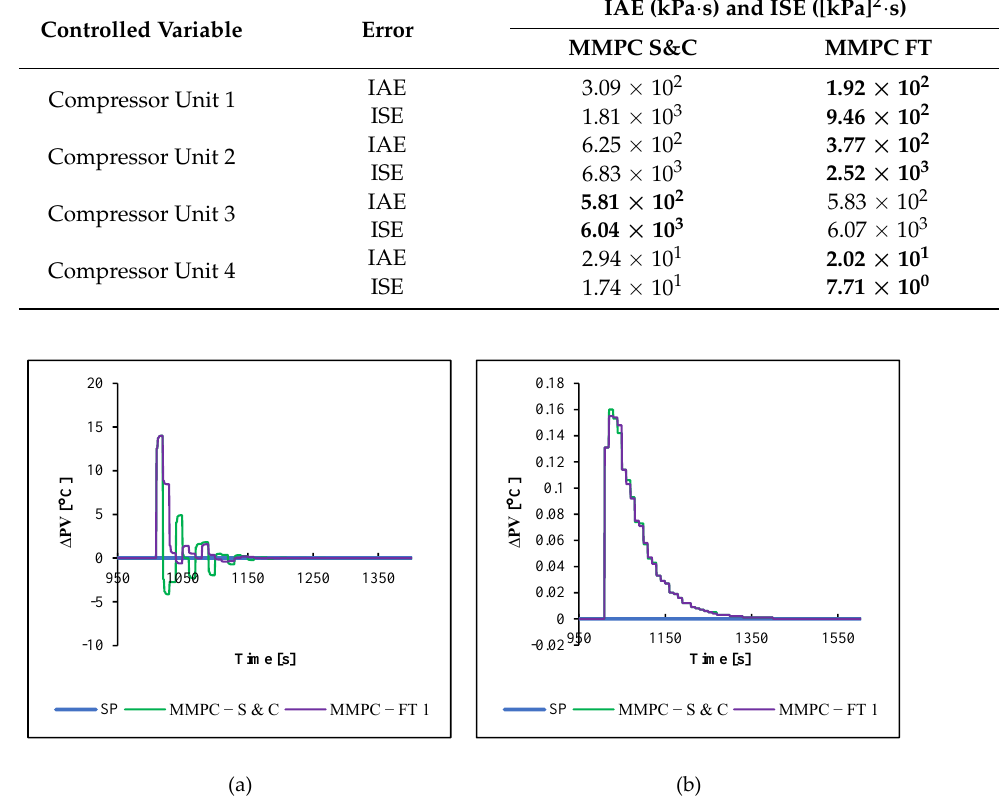
Figure 14. Controller performance on: ( a ) the heater and ( b ) the combustor (Disturbance Test). Table 20. Comparison of controller performance on the steam reformer unit (Disturbance Table 19. Comparison of controller performance on the compressor unit (Disturbance Test).